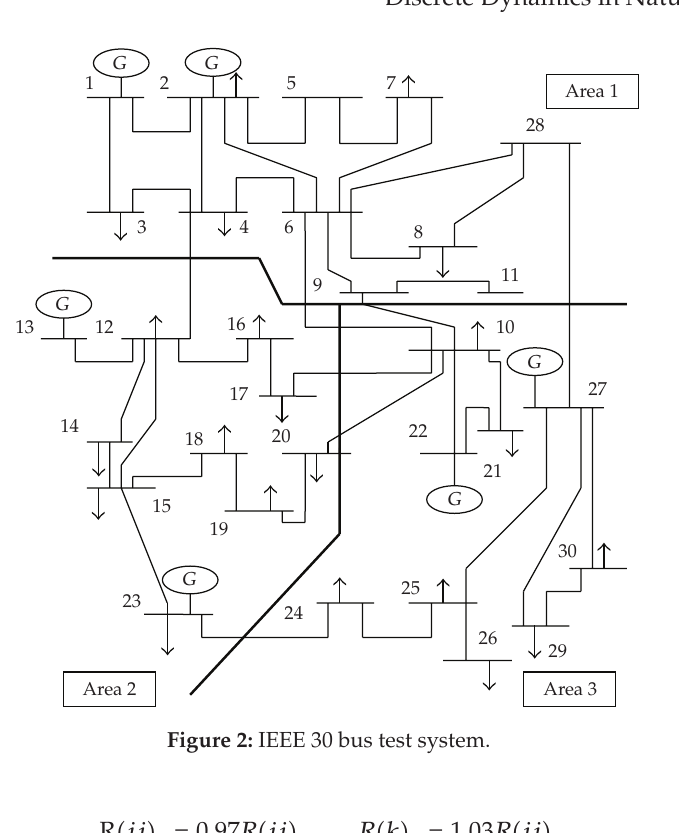
Figure 2: IEEE 30 bus test